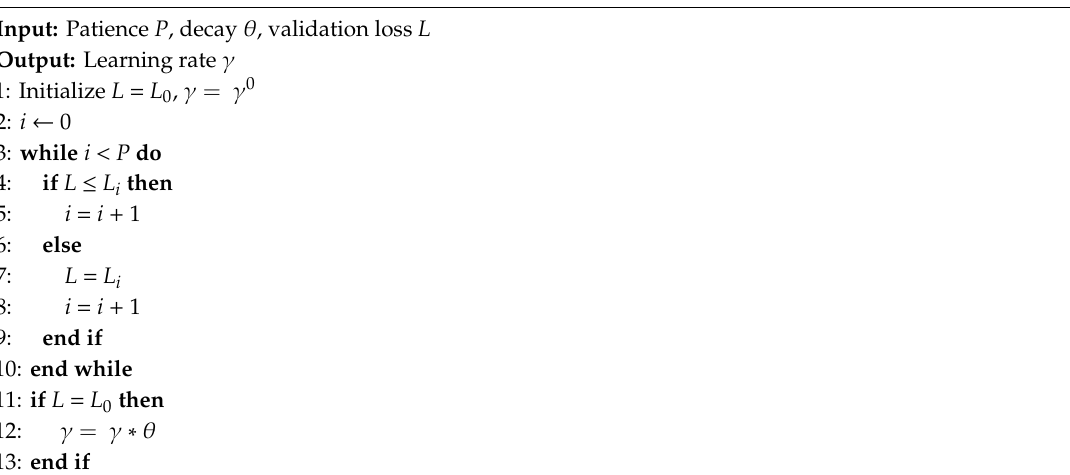
Algorithm 1. Learning Rate Schedule